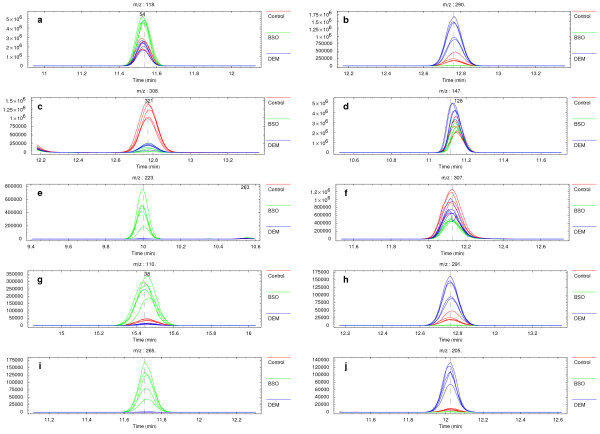
Candidate differences. Overlaid extracted ion electropherograms for the most significant differences from the three-way comparison results shown in Figure 3. Each panel represents data in the form of signal intensity (number of ions) over time for a specific mass interval (1 Da bin). The vertical dashed line indicates the position of the most significant difference according to the three-way comparison results. When present within panels, numbers correspond to the annotation labels in Figures 2 and 3.